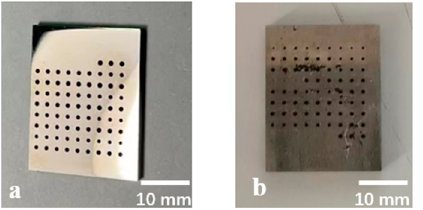
Figure 7. Macro morphology of femtosecond laser drilling samples ( a ) front; ( b ) back.